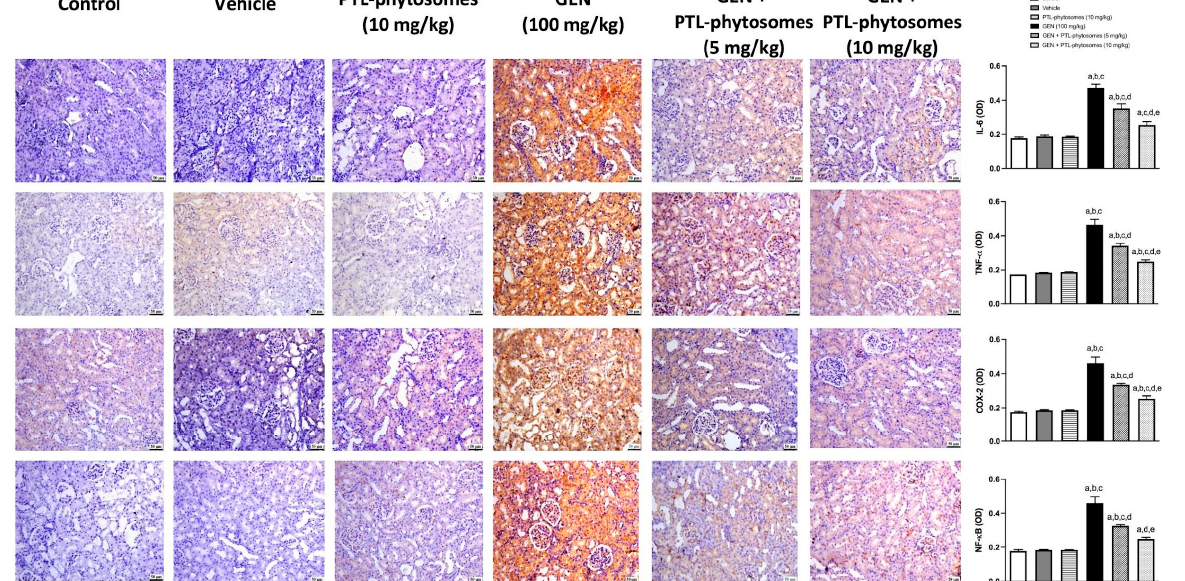
Figure 8. PTL-phytosomes activated the antioxidant defense system. ( A ) Western blot analysis to different experimental groups, I control, II vehicle, III PTL-phytosomes (10 mg/kg), IV GEN (100 mg/kg), V GEN + PTL-phytosomes (5 mg/kg), and (VI) GEN + PTL-phytosomes (10 mg/kg). The semi-quantification of ( B ) Sirt-1, ( C ) Nrf2, ( D ) NQO1, and ( E ) HO-1 expression was achieved. Data are expressed as Mean ± SD ( n = 6). a: significant when compared to control at p < 0.05; b: significant when compared to vehicle at p < 0.05; c: significant when compared to PTL-phytosomes at p < 0.05; d: significant when compared to GEN-alone at p < 0.05; e: significant when compared to GEN + PTL-phytosomes (5 mg/kg) at p < 0.05.